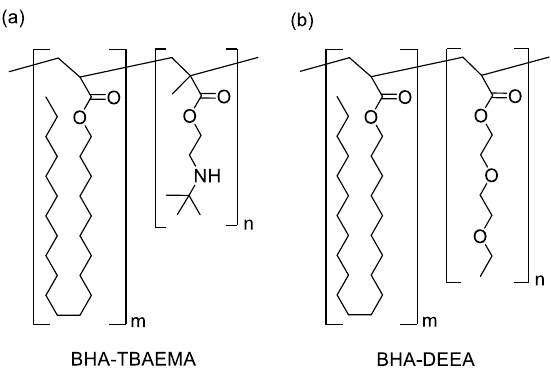
Figure 1. Chemical structure of SCCBCs ( a ) BHA-TBAEMA; ( b ) BHA-DEEA.